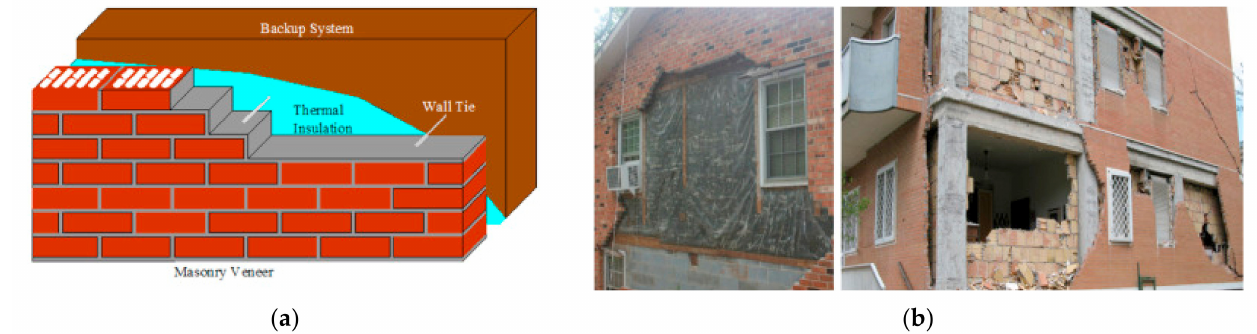
Figure 1. ( a ) Typical configuration of veneer wall systems [1]; ( b ) examples of damage caused by the earthquakes of Lorca, Spain (in 2011) and L’Aquila, Italy (in 2009) [1]. Moreover, due to their mass and connection to the backing structural system, veneer walls influence the overall dynamic response of the building under seismic actions